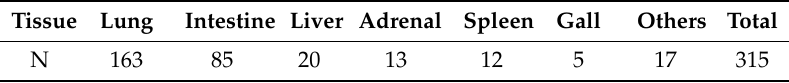
Table 2. The distribution of examined organ